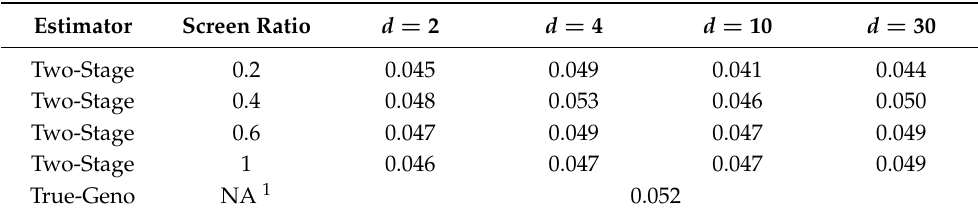
Table 1. Type 1 Errors without Multiple Test Adjustment for Binary Phenotype with Average